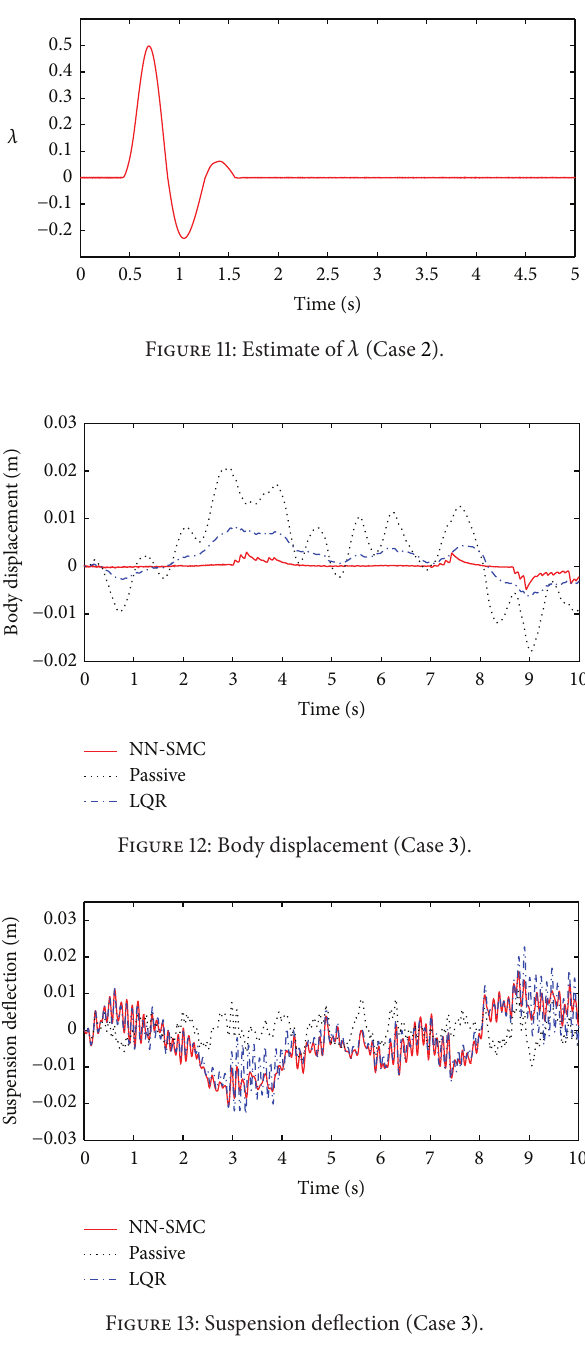
value of the body acceleration with NN-SMC is 4.1 × 10 −2 , which is slightly larger than the RMS value 3.7 × 10 −2 by LQR.